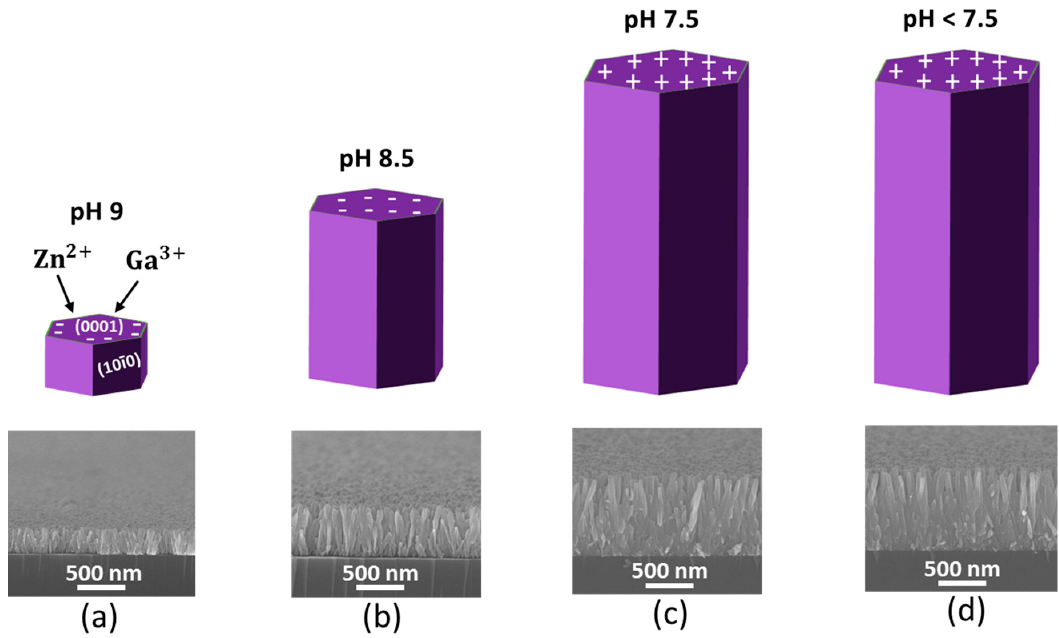
Figure 4. GZR isoelectric point-dependent growth mechanism with their corresponding cross-sectional SEM images at ( a ) 30 min; ( b ) 2 h; ( c ) 4 h; and ( d ) 6 h.